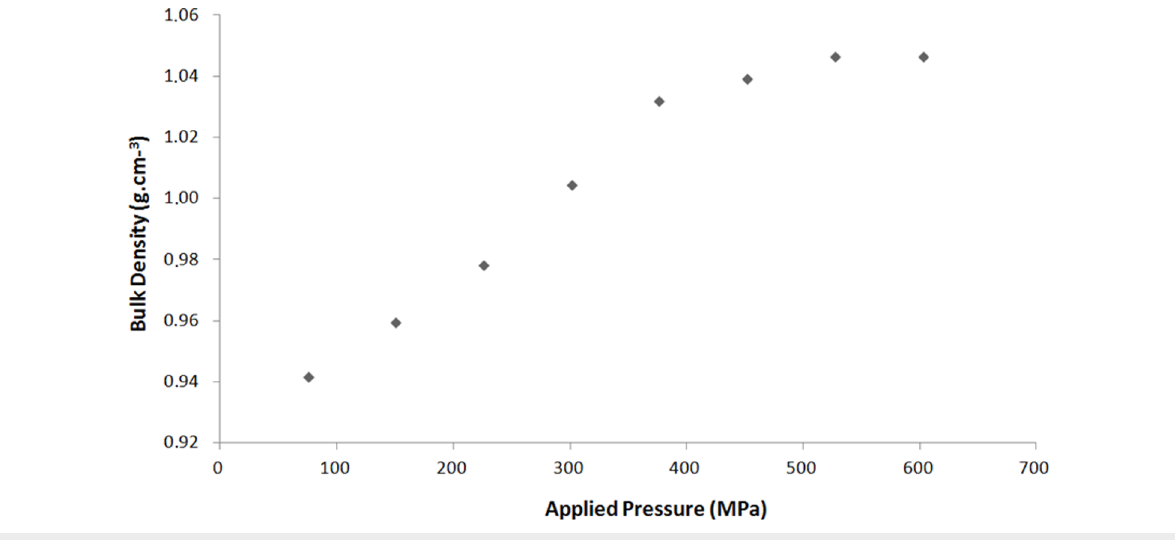
approximated by a second order equation according to the DOE methodology. The best-fit parameters are obtained by mini- mizing a quadratic criterion. The obtained model is: